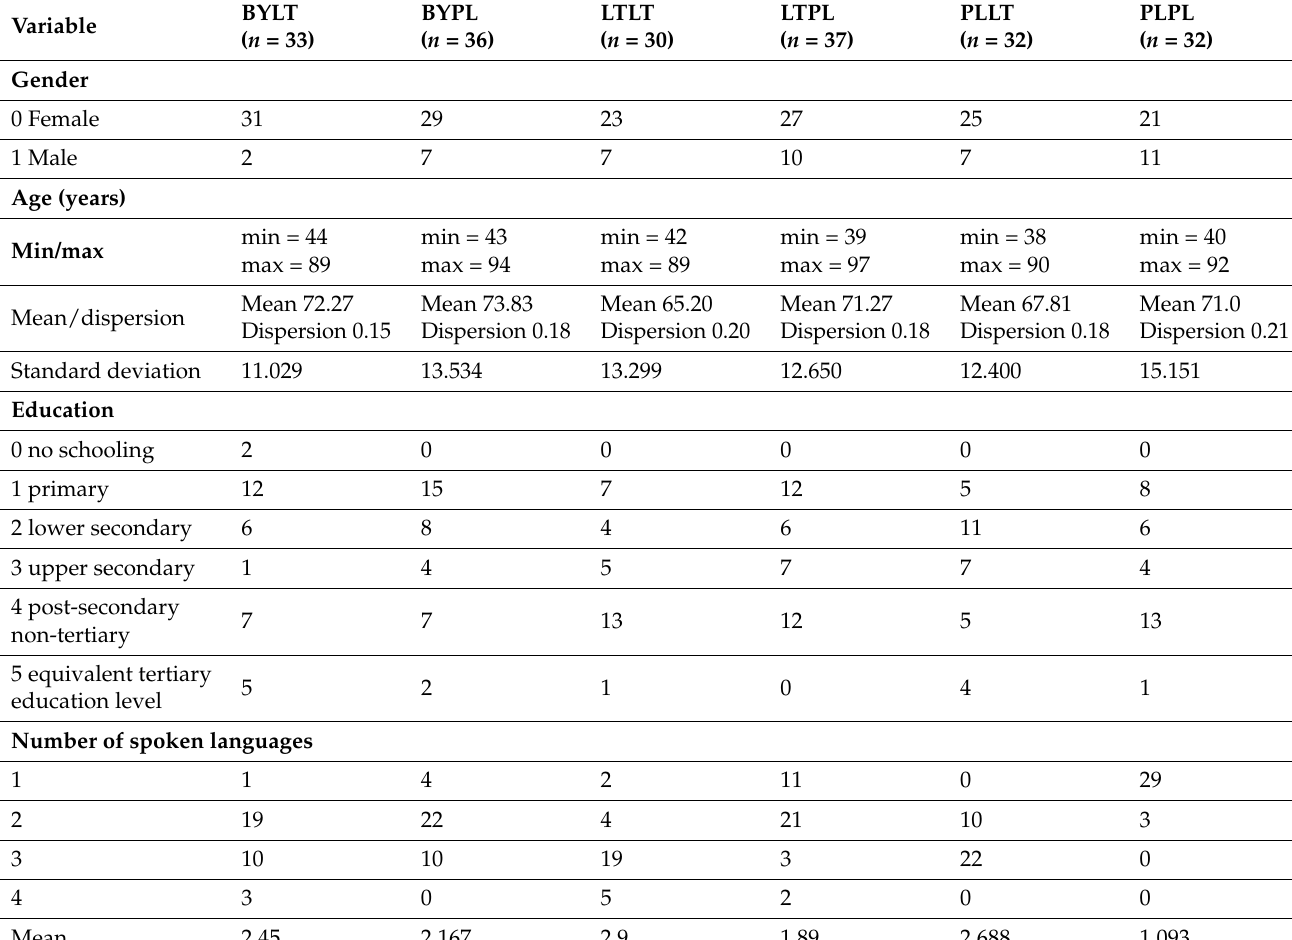
Table 1. Sample distribution by gender, age, education, and